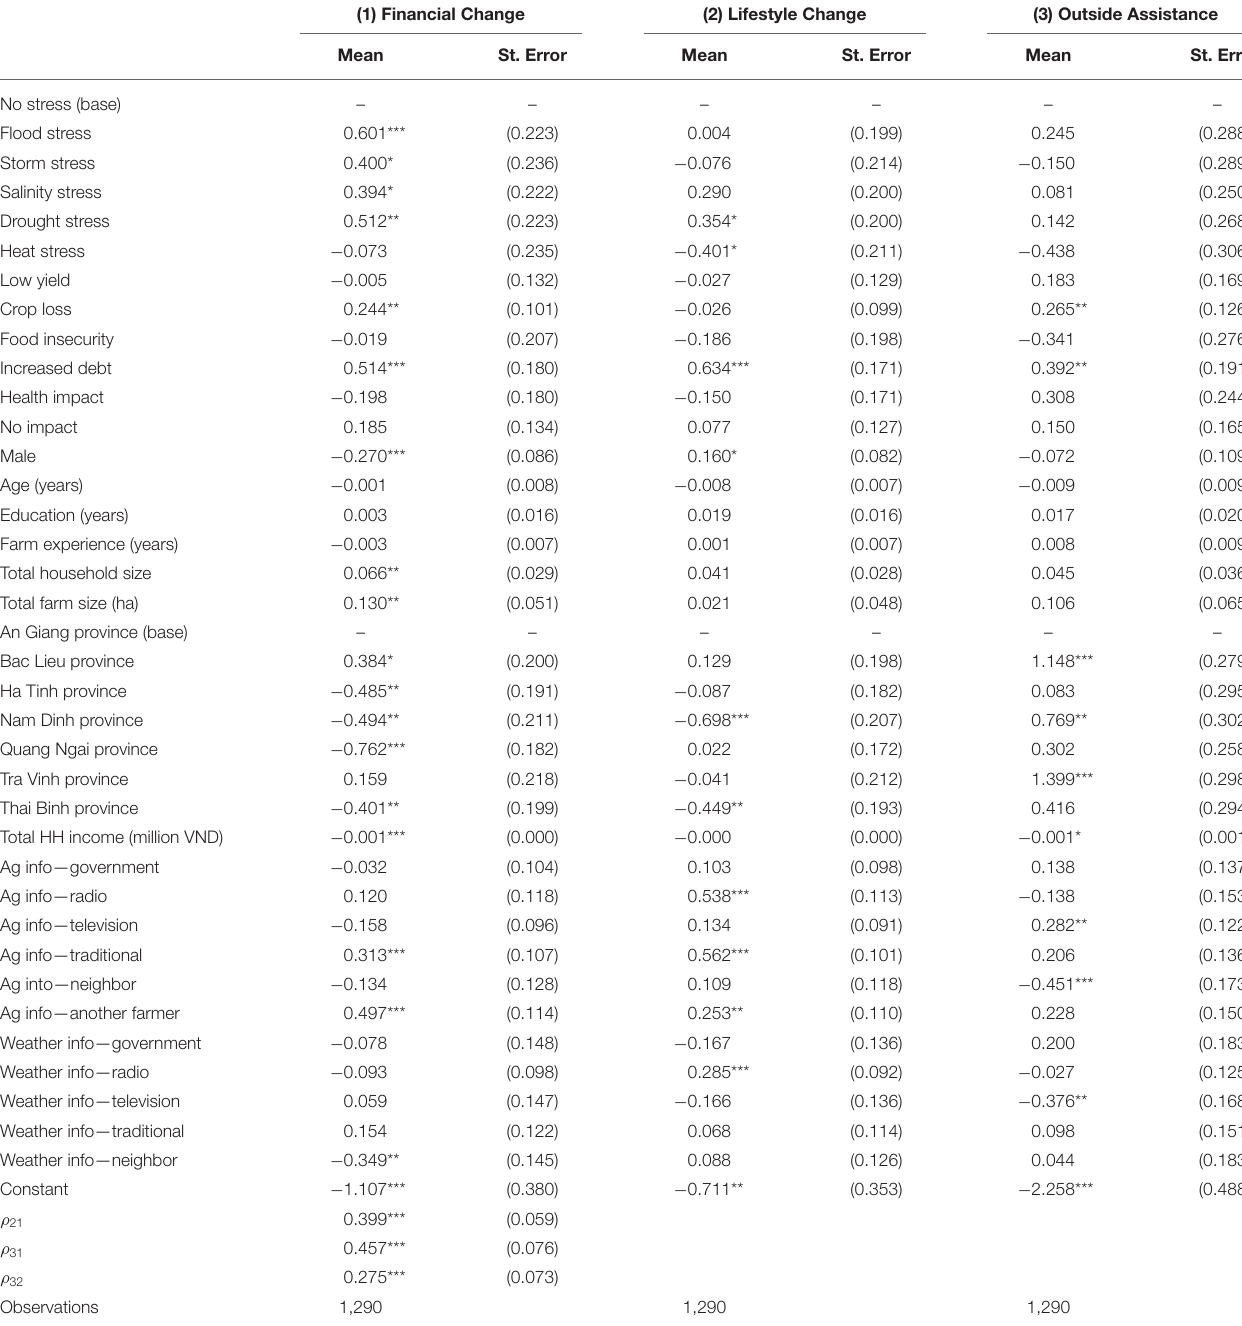
TABLE 2 | Multivariate probit results, individual coping strategies to climate